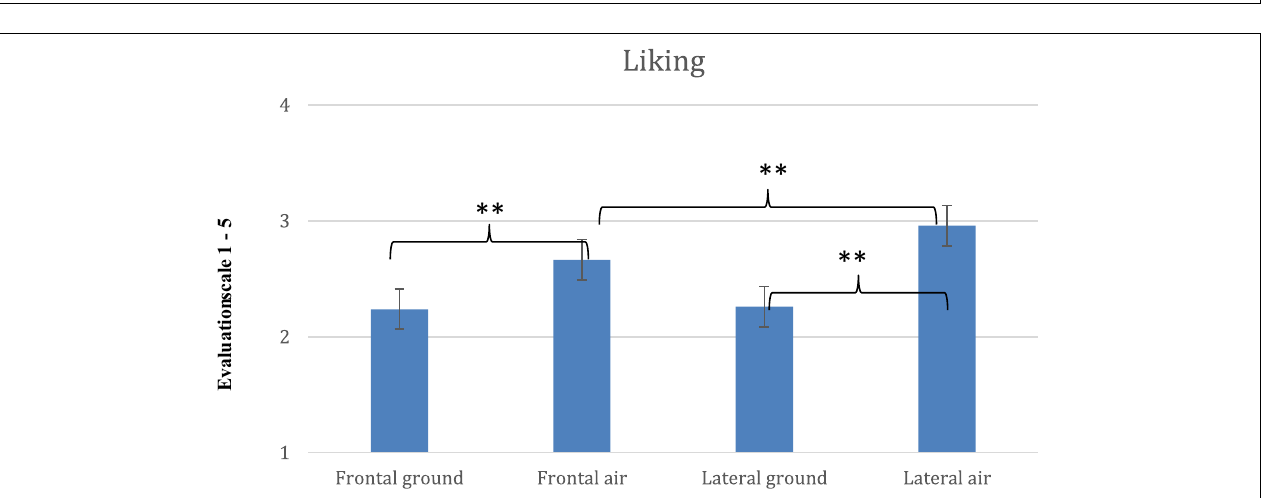
FIGURE 5 | Mean scores for Difficulty and significant interaction for the four poses, Frontal On-ground , Lateral On-ground , Frontal In-air and Lateral In-air (error bars indicate standard errors of the means; ∗ = < 0.05; ∗∗ = < 0.001).